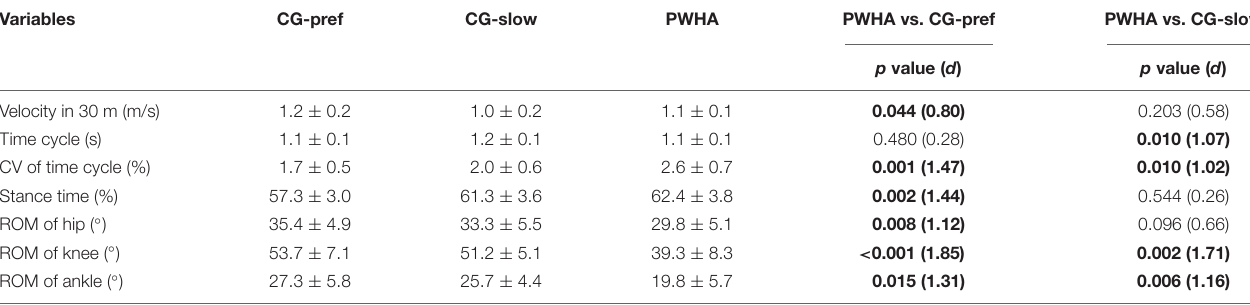
TABLE 4 | Temporal variables and total range of motion (ROM) during walking.